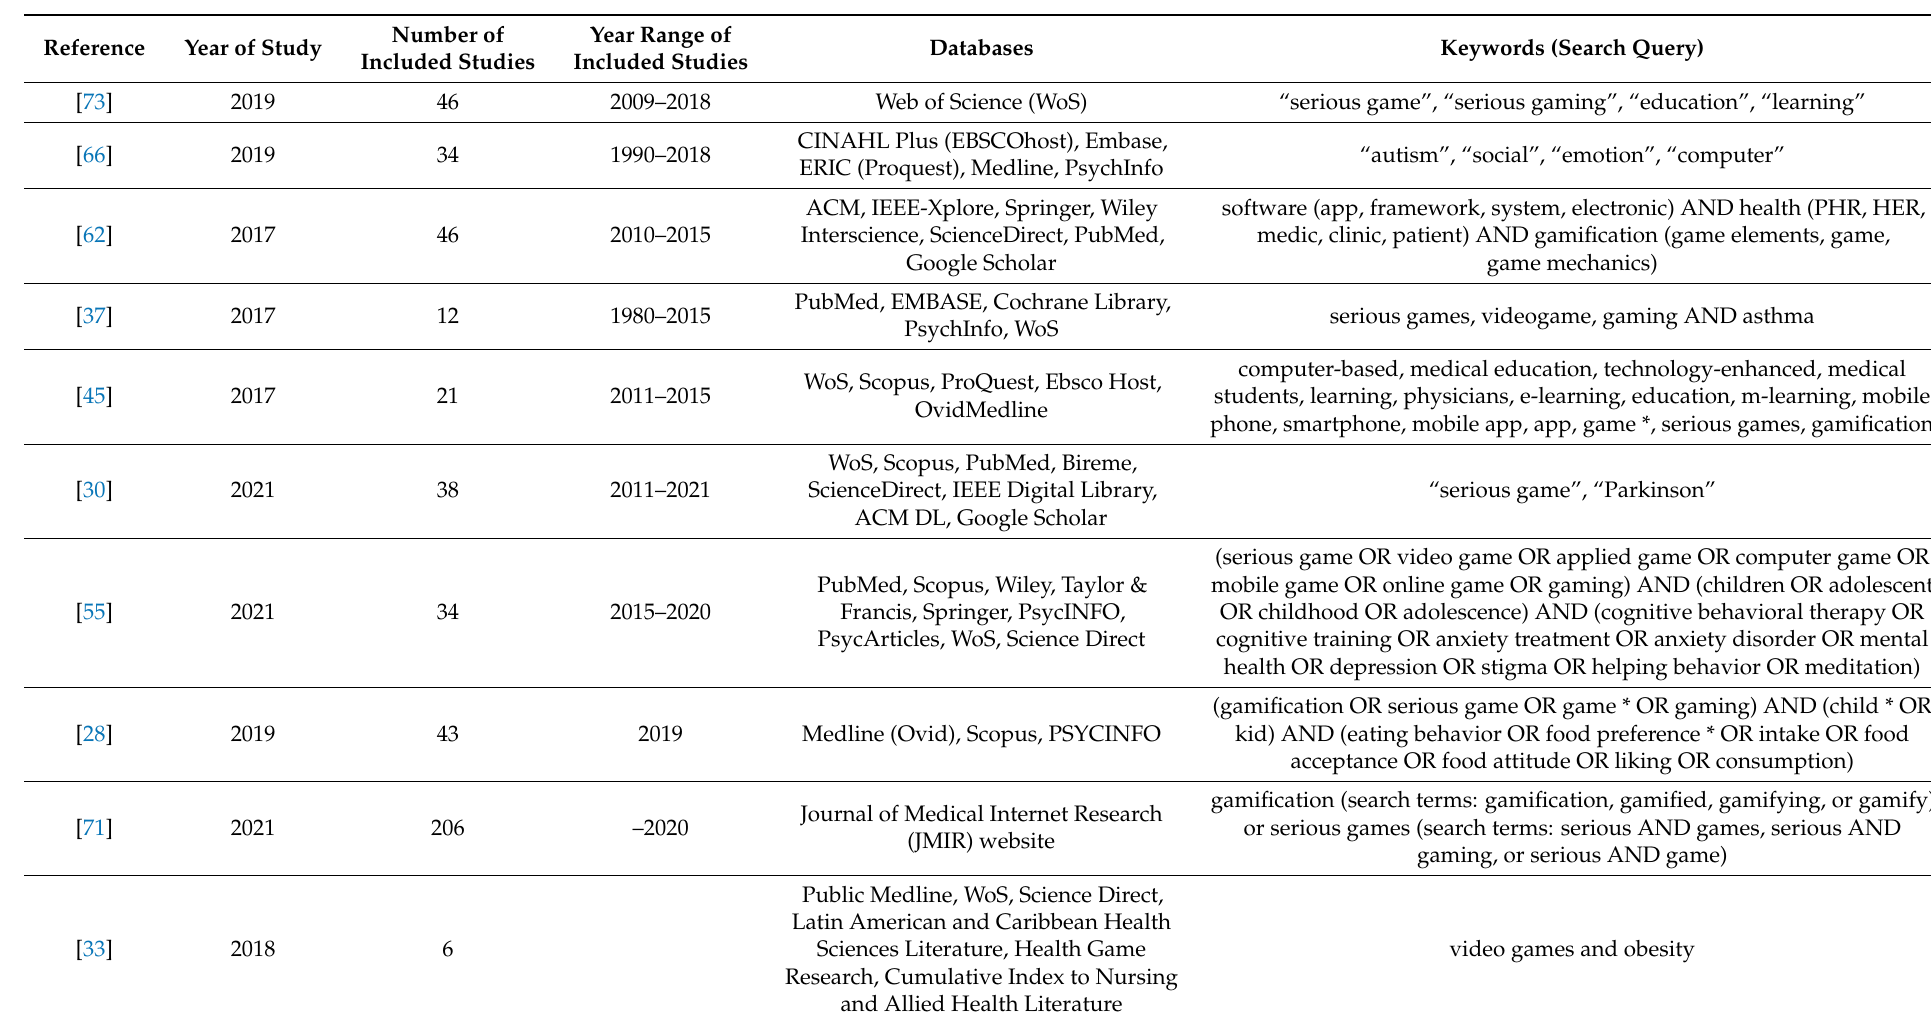
Table 10. Characteristics of the systematic reviews and reviews and the studies included within